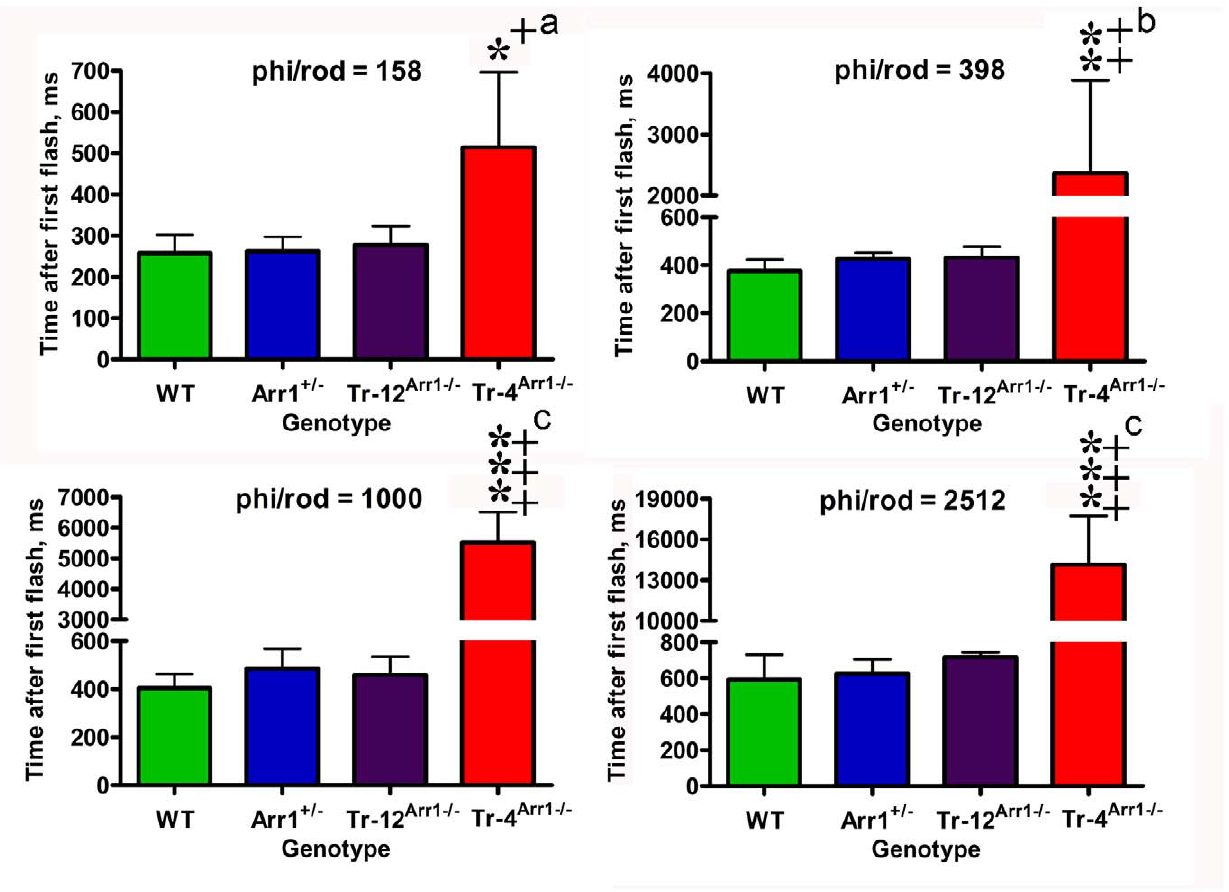
Figure 2. Animals with very low arrestin-1 in the OS show very long time of half recovery. To calculate the time of half recovery, recovery kinetics were fitted by polynomial nonlinear regression, with R 2 . 0.95, as described in methods. Means + / 2 SD for four animals per genotype are shown. The data were analyzed by one-way ANOVA with Genotype as main factor followed by Bonferroni post hoc comparison of means. * - p , 0.05; ** - p , .001, *** - p , 0.001 to WT; + - p , 0.05, ++ - p , 0.001, +++ - p , 0.001 to Arr + / 2 , a – p , 0.005, b – p , 0.01, c – p , 0.001 to Tr-12 Arr 2 / 2 . Phi/rod, photoisomerizations/rod.